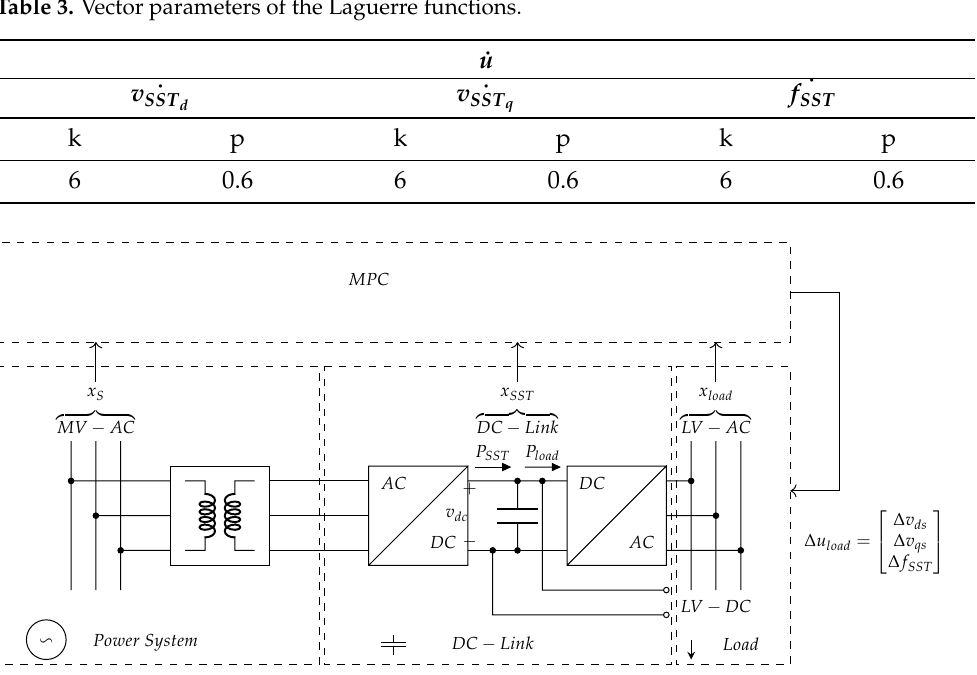
Table 3. Vector parameters of the Laguerre functions.